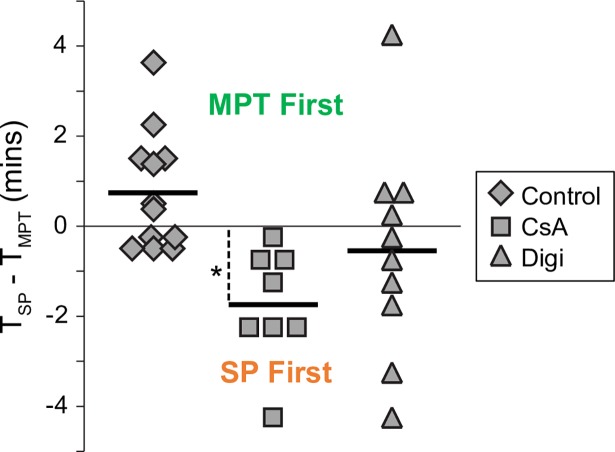
The summary of the time difference between the MPT and SP events (TSP-TMPT) in individual myocytes from the three experimental groups as indicated.Thick horizontal bars show average values. Note that CsA increases separation between MPT and SP, such that TSP-TMPT is significantly negative. *, p < 0.01.